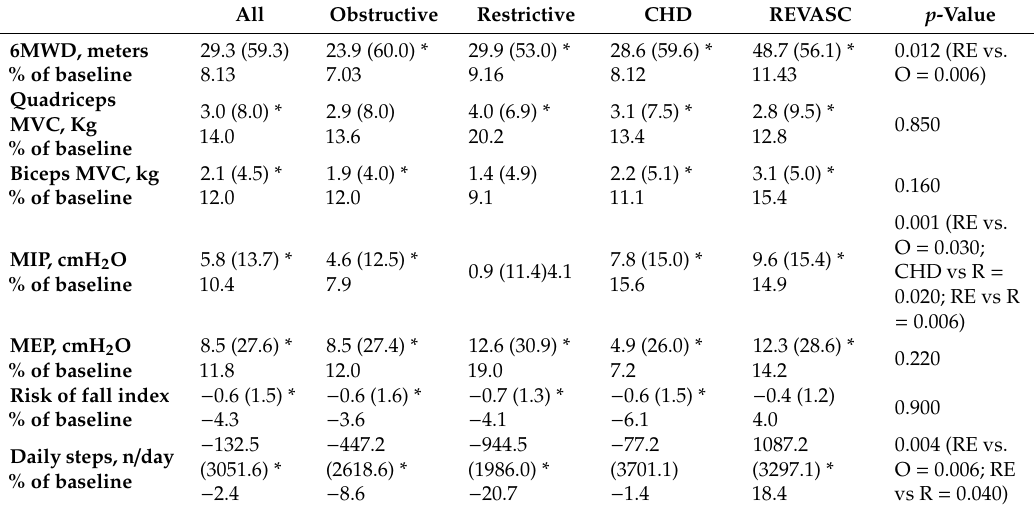
Table 4. Post training delta changes in outcomes measures (delta absolute value and delta % of